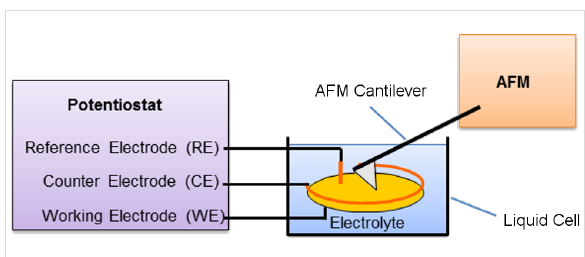
Figure 1: Schematic diagram of an electrochemical atomic force microscope, comprising an atomic force microscope with a laser-beam detection system (not shown), an electrochemical liquid cell with refer- ence electrode (RE), counter electrode (CE) and working